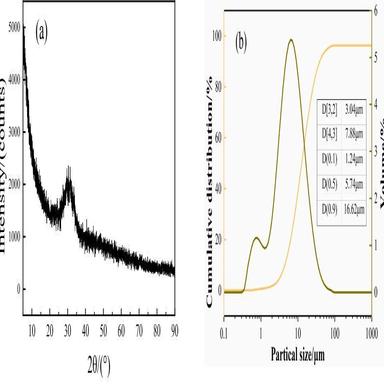
Characteristics of BFS. (a) XRD pattern of BFS. (b) Particle size of BFS.